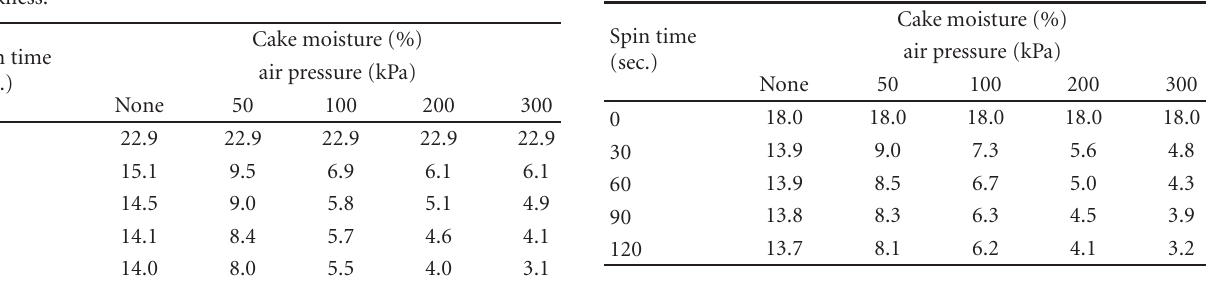
Table 6: E ff ects of G -force and air pressure on the dewatering of chalcopyrite sample ( − 150 μ m) at 2,000 G -force and 1.5cm cake thickness.